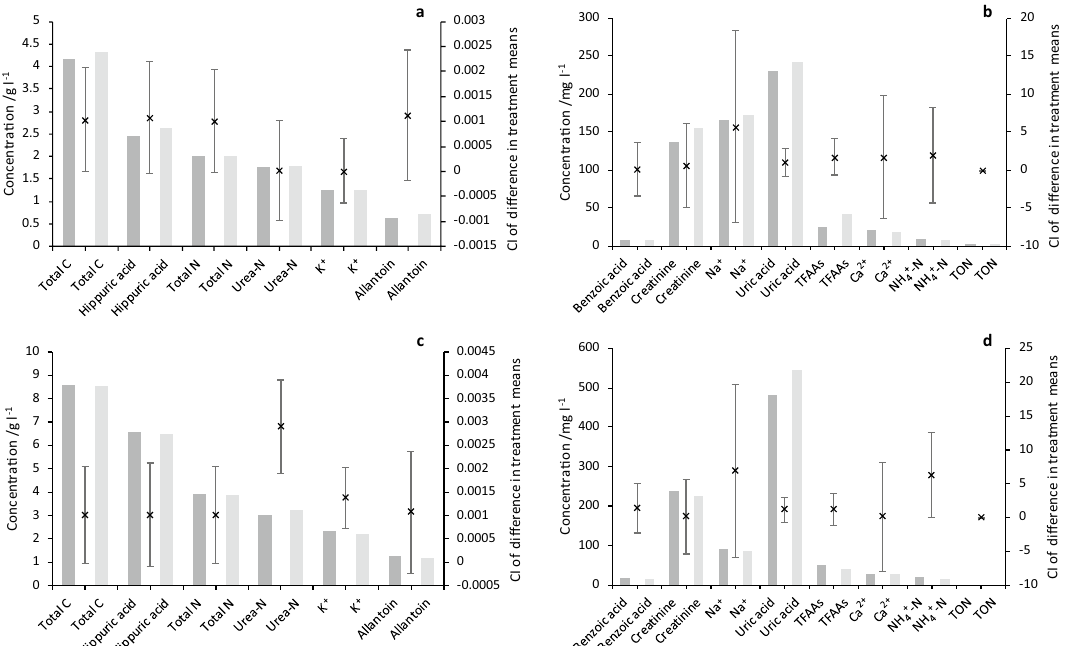
Figure 3. FD-2. Mean non-freeze-dried (darker bars; N) and freeze-dried (lighter bars; F) urine composition data: ( a – b ) Low concentration mixtures (LM), ( c )–( d ) High concentration mixtures (HM; Supplementary Table 1), ( a ) and ( c ) Constituents with mean concentrations over 1 g l −1 , ( b ) and ( d ) Constituents with mean concentrations under 600 mg l −1 . Error bars show the CI of the difference between the treatment means (N vs. F; n = 3) and are centred on the difference between the